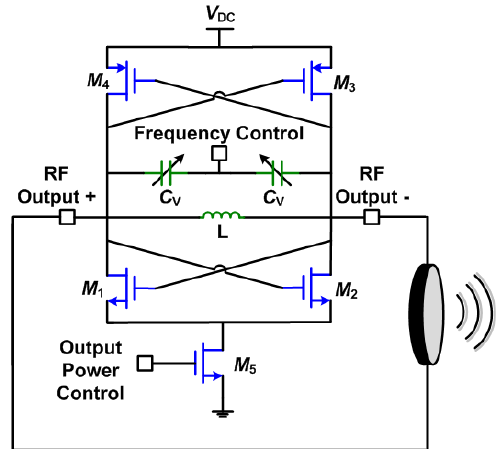
Figure 13. Schematic of a direct-modulation